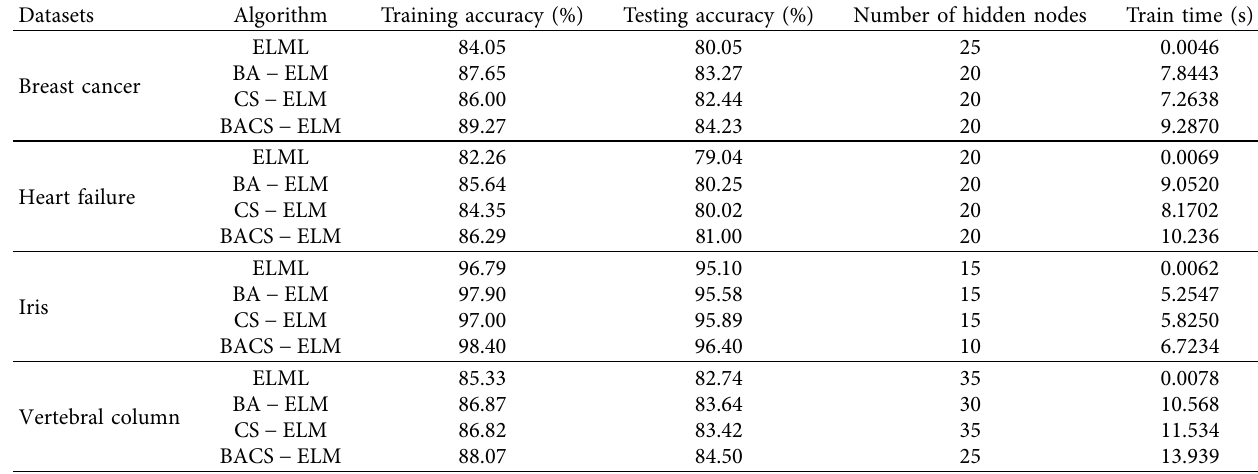
Table 7: Performance comparison for classification